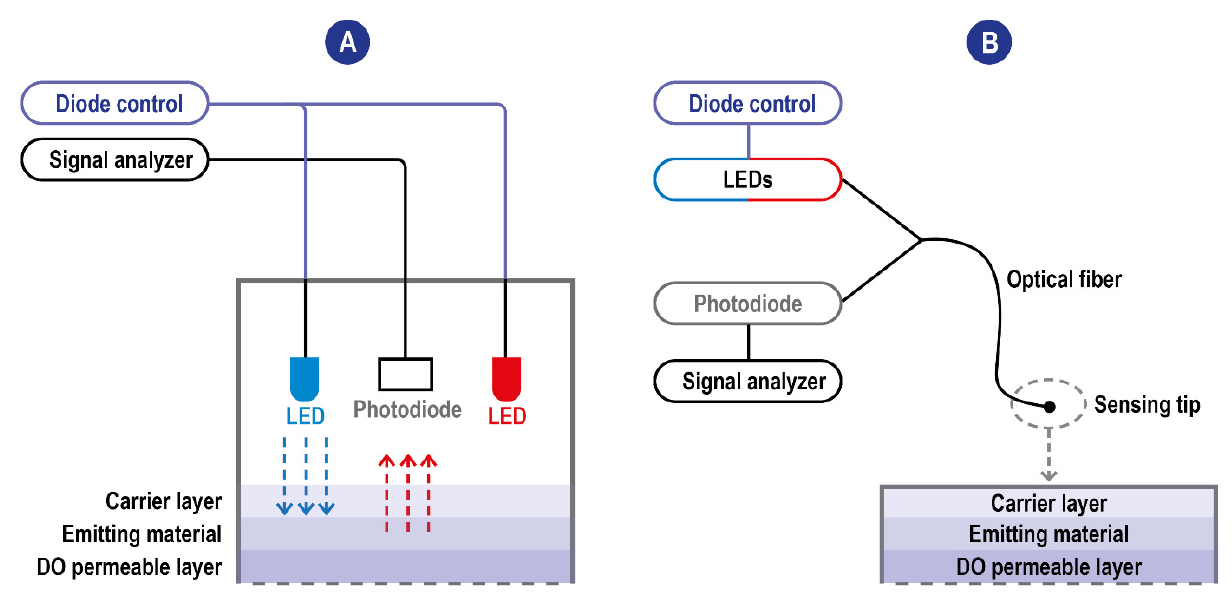
Figure 4. ( A ) Scheme of typical fluorescence quenching-based DO sensors. The blue excitation LED is the one used for the excitation of the emitting material. The red one is used instead as an internal reference. When these sensors exploit the modulation technique, the blue LED is modulated to a frequency related to the luminophore’s luminescence lifetime and the upper and lower lifetimes. Blue arrow: LED emission; red arrow: fluorescence ( B ) Scheme of typical fluorescence quenching-based DO sensors with optic fiber technology. The detector and the light sources communicate are not integrated into the sensing tip and communicate with it through the fiber allowing the miniaturization of the sensing probe.